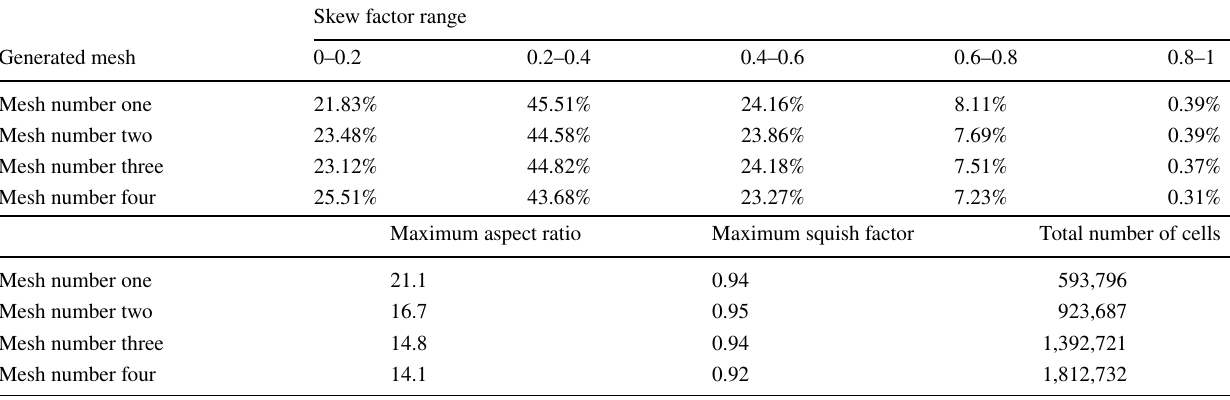
Table 5 Global mesh quality for different meshing system of Case 3